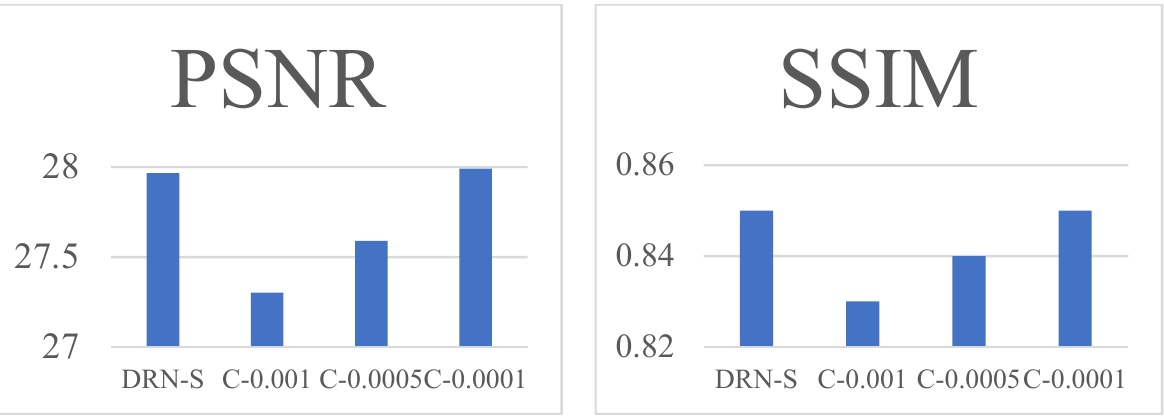
Figure 5. The PSNR and SSIM varied from the weighting of contextual loss.